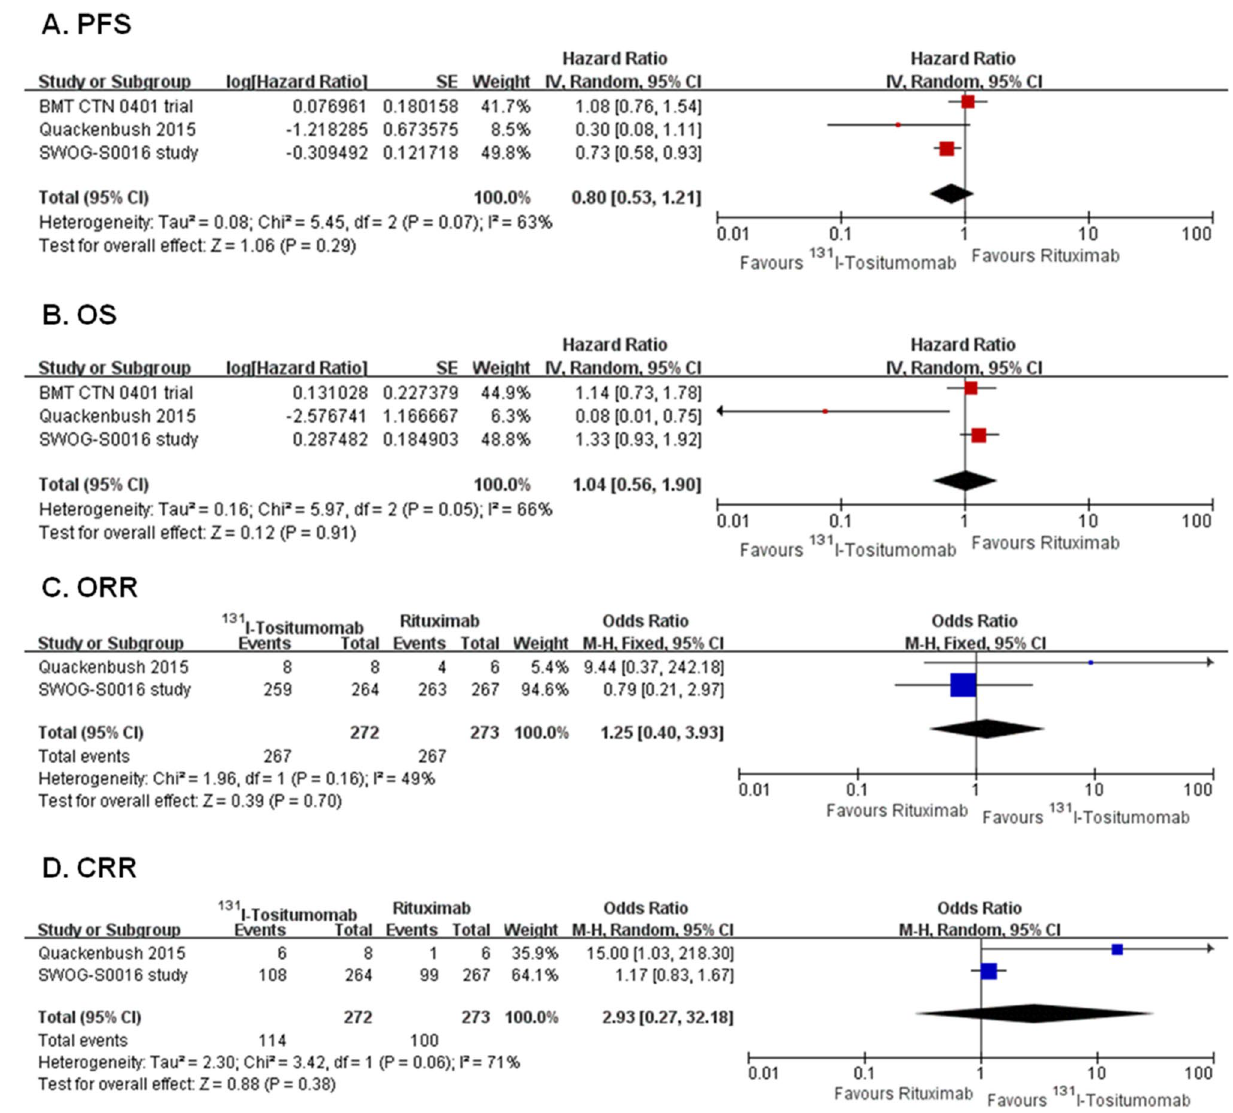
Figure 4. Forest plots of 131 I-tositumomab versus rituximab. Forest plot of the meta-analysis that estimating the ORs and HRs with their corresponding 95% CIs for the 131 I-tositumomab group, compared with that in the rituximab group. PFS progression-free survival, OS overall survival, ORR overall response rate, CRR complete response rate, HRs hazard ratios, ORs odds ratios, 95% CI 95% confidence